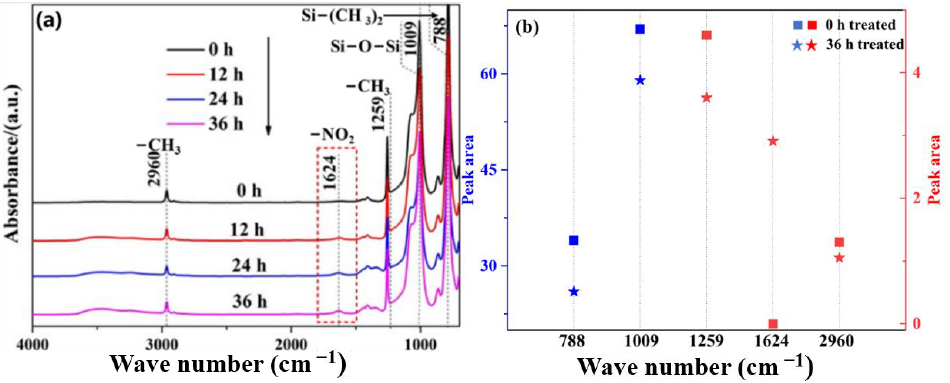
Figure 5. Infrared spectrum ( a ) and organic group peak area changes ( b ) in ATH-0 SiR after aging with NO 2 for different times.